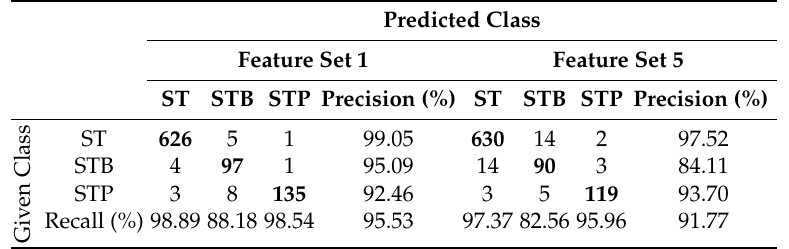
Table 10. Confusion metrics for fs1 and fs5 at the TP position achieved through DT.